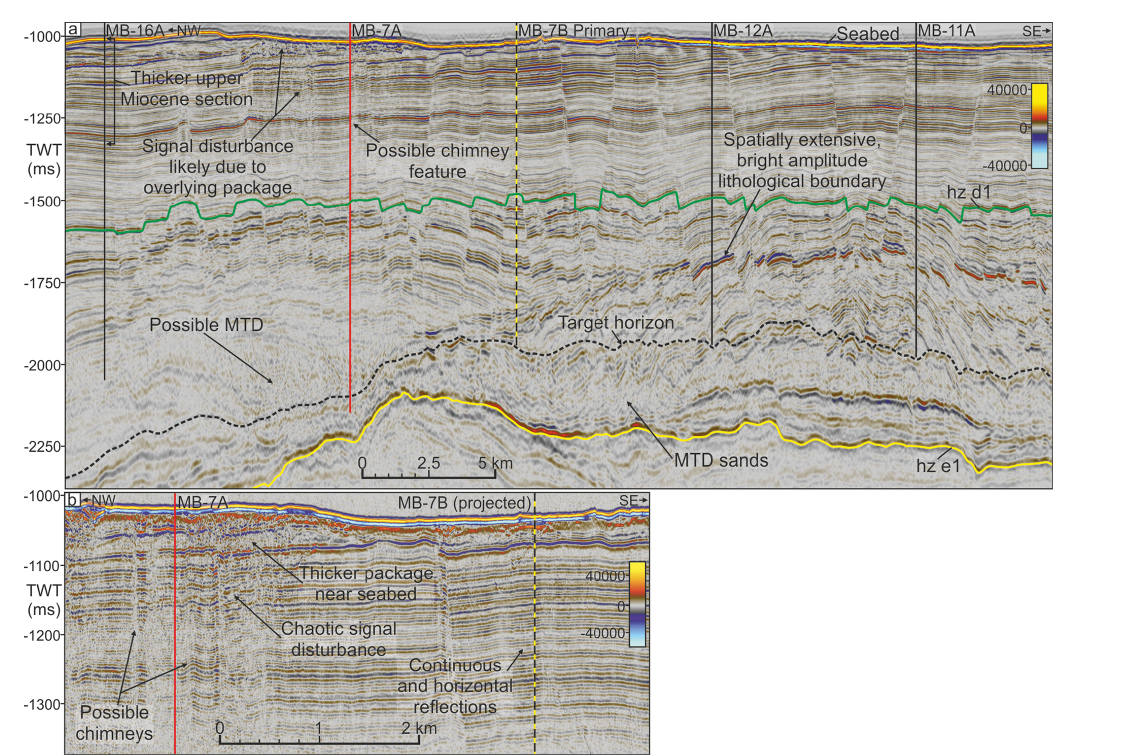
Figure 14. Target VII. (a) A seismic cross section from the Pitu HR survey that displays the location of primary site MB-7B, the alternate sites MB-16A, MB-12A and MB-11A and the abandoned site MB-7A. Regional seismic mega-unit interpretations are shown as well as the target seismic horizon used to define the depth target used within the CRS map in Fig. 10 that represents the top of a potentially sandy MTD package. (b) A seismic cross section from the LAKO UHR seismic that shows potentially hazardous seismic features near site MB-7A that are also observed in the Pitu HR survey (shown in panel a ) and ultimately led to the abandonment of that site. A projection of primary site MB-7B is also shown penetrating a section containing continuous and horizontal seismic reflections. The locations of panels (a) and (b) are shown in Fig. 3, and uninterpreted versions are provided in Fig.